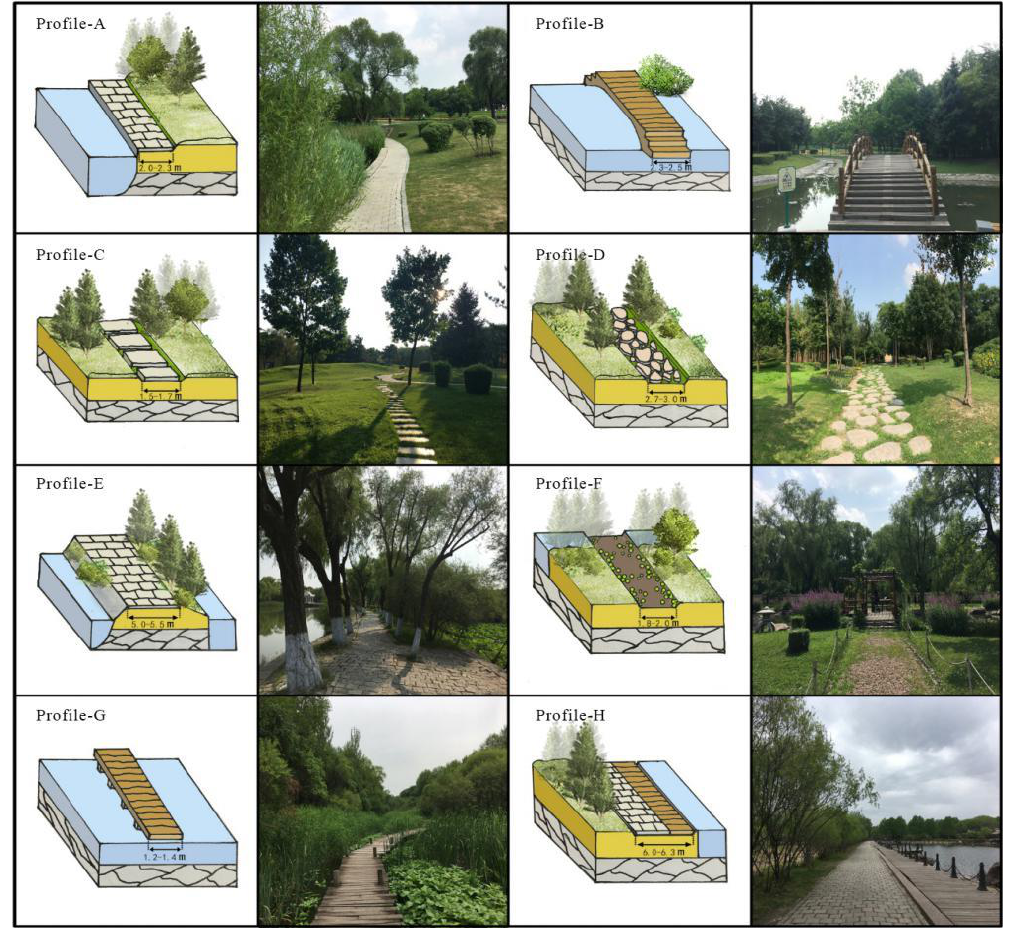
Figure 2. Profile pattern.